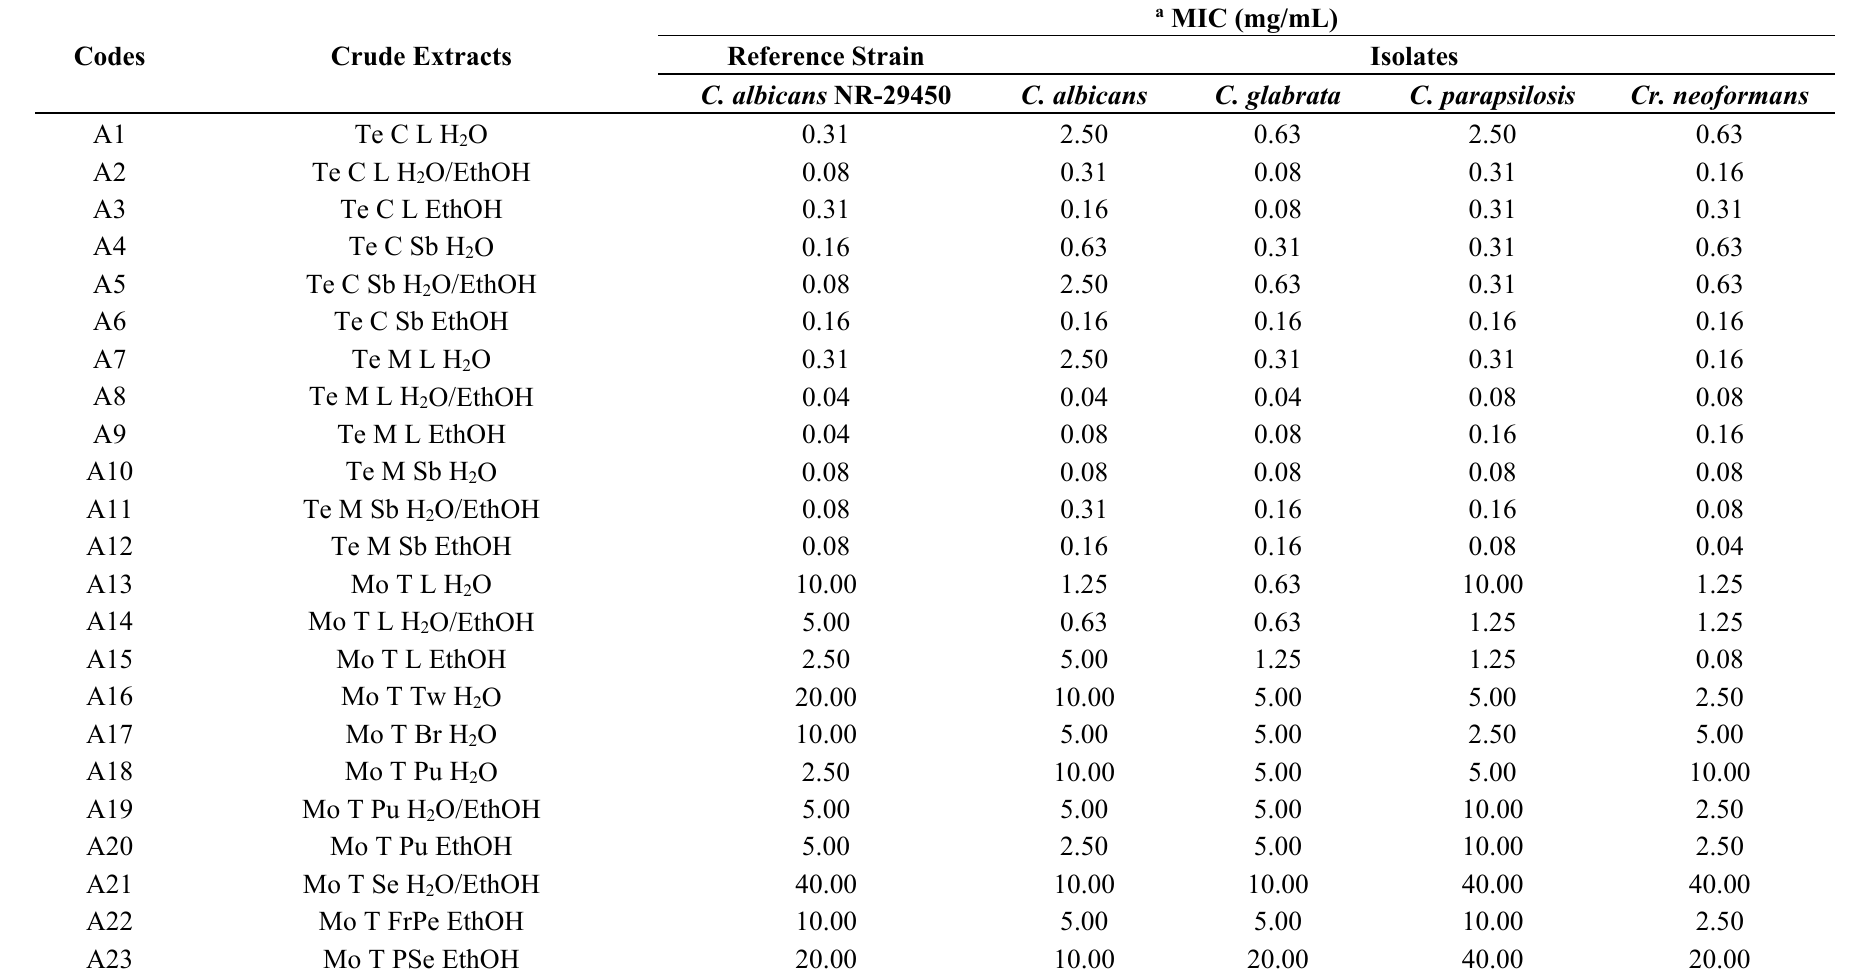
Table 1. Minimal inhibitory concentrations (MIC) of crude extracts, fractions and